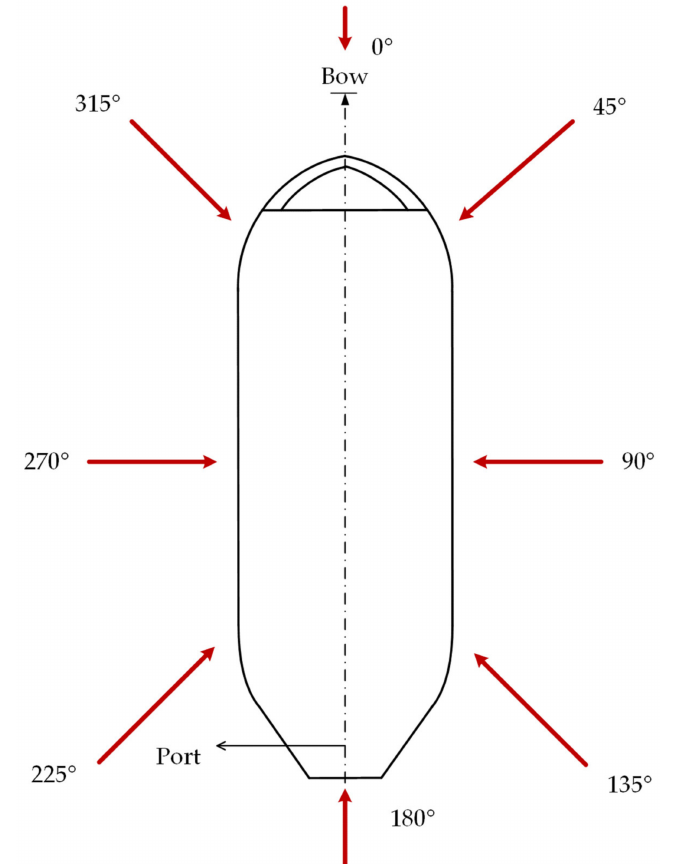
Figure 5. Definition of wind direction relative to ships.